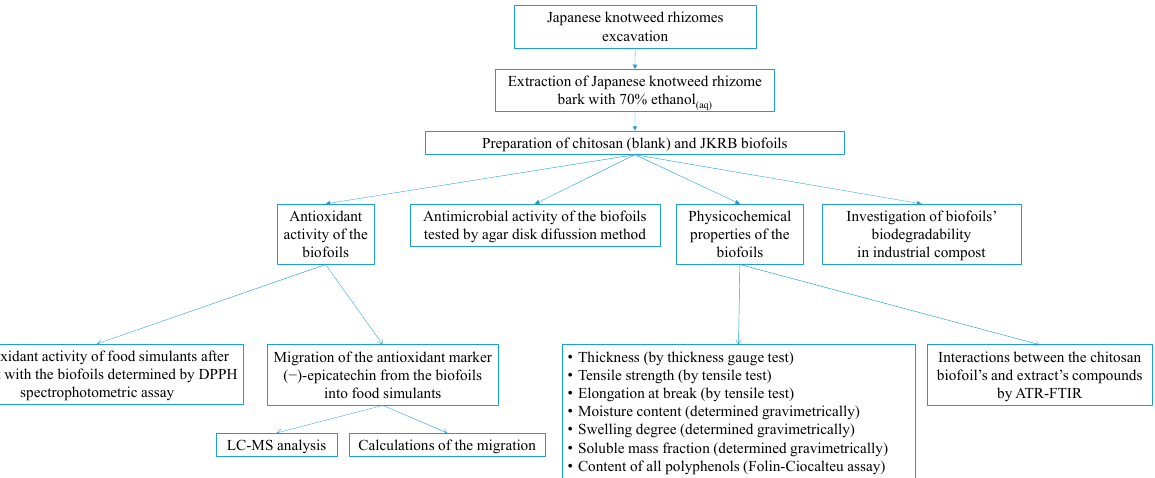
Japanese knotweed rhizomes excavation Extraction of Japanese knotweed rhizome bark with 70% ethanol (aq) Preparation of chitosan (blank) and JKRB biofoils